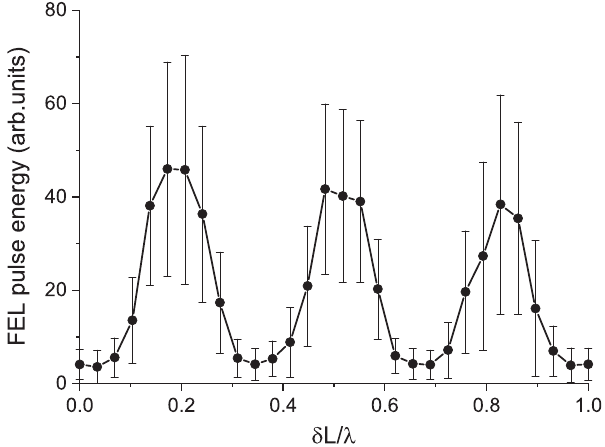
FIG. 3. Synchronous scan of phase shifters after first four undulator segments. FEL pulse energy is measured after the second part of the undulator tuned to 2.1 keV. Mean pulse energy and its standard deviation are plotted versus a delay measured in units of the fundamental wavelength in the first part (tuned to 700 eV). FEL operates in “ 5 þ 6 segments HLSS ” mode.